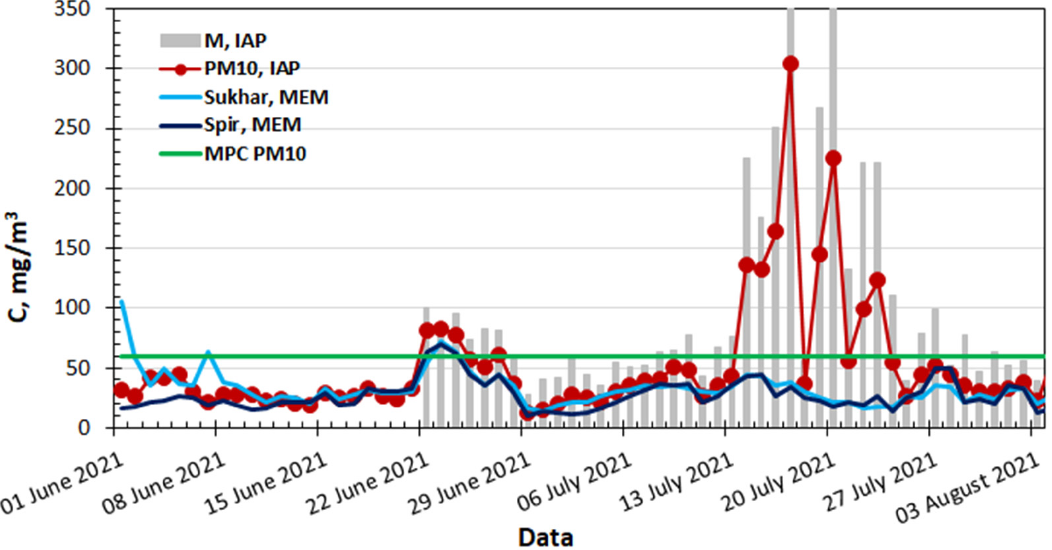
Figure 10. The average daily mass concentration of PM 10 particles and the total aerosol mass (M) in the summer of 2021 before, during and after episode No. 6 of extreme aerosol pollution (according to observations by IAP and MEM). The green line indicates the MPC value for daily PM 10 mass concentration.